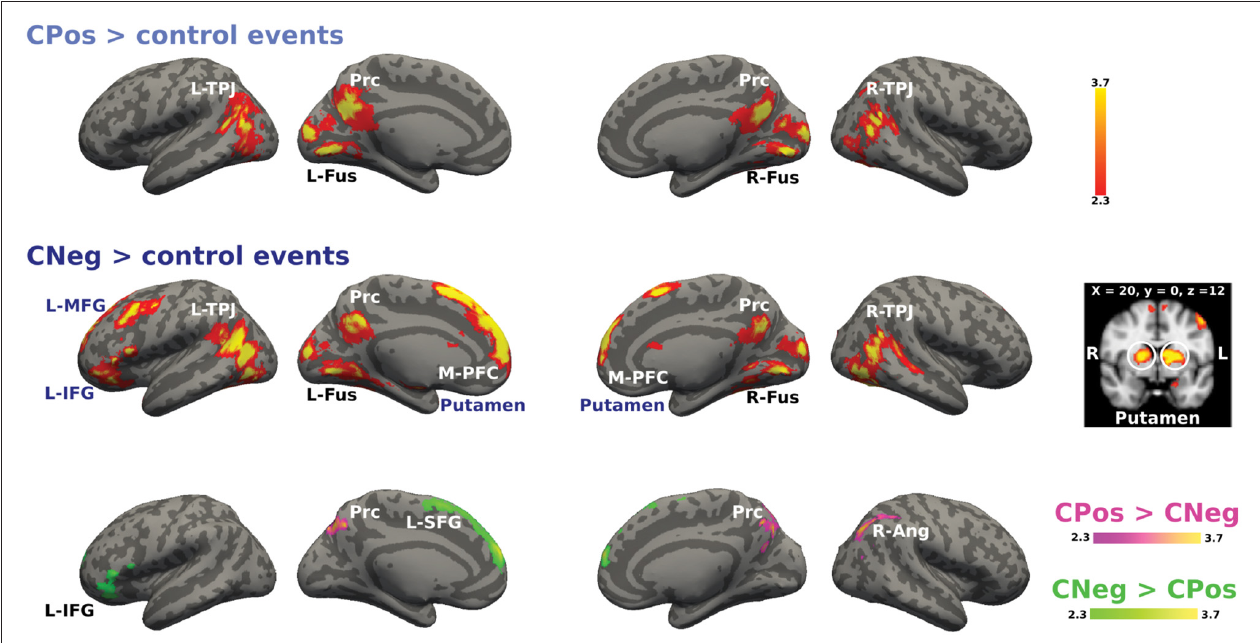
FIGURE 6 | Activation maps for the cooperative confederate situational events. A whole-brain contrast for cooperative confederate in positive situations with respect to control events (CPos > control events) revealed increased activity in bilateral TPJ, Prc and bilateral cortex fusiform (Fus). Additionally, contrast for cooperative confederate in negative situations with respect to control events (CNeg > control events), includes increased activity in M-PFC, left inferior and MFG (L-IFG, L-MFG) and putamen. Color bar indicates z